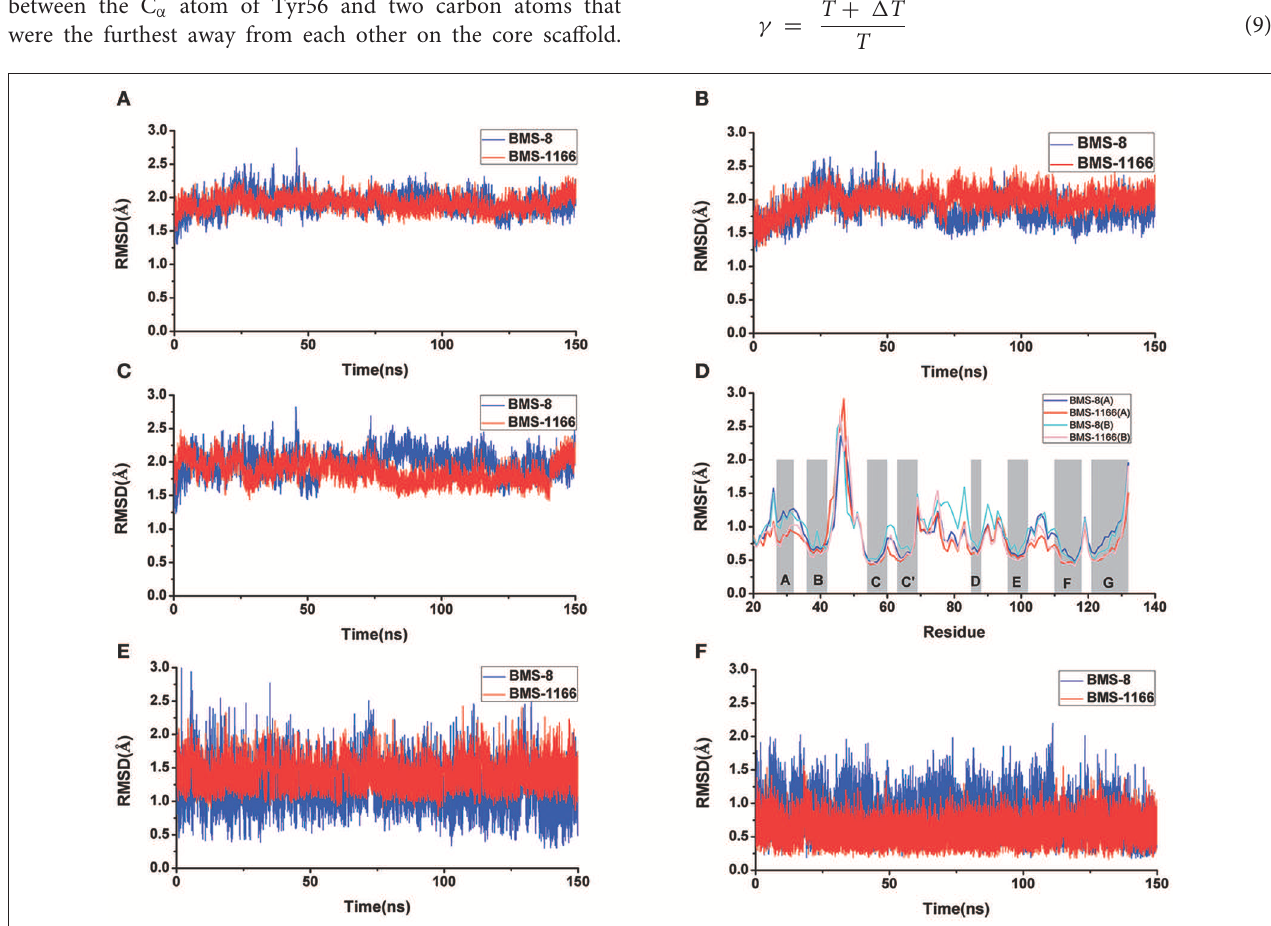
FIGURE 3 | The RMSDs and RMSFs of the heavy atoms in dimer systems. (A) RMSD of complex, (B) RMSD of PD-L1 at conformation A, (C) RMSD of PD-L1 at conformation B, (D) RMSF of residues on PD-L1 at conformation A, B, (E) RMSD of the ligand, and (F) RMSD of the core scaffold.